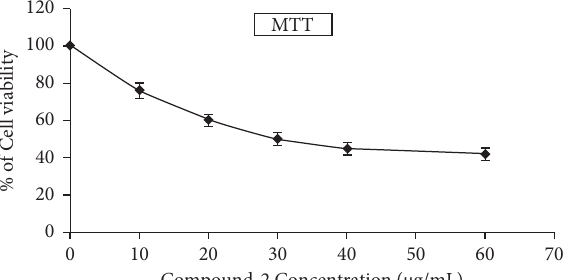
Figure 8: Effect of compound 2 on the viability of ovarian cancer cells. HO-8910 (1 × 10 4 /well) cells were cultured in RPMI 1640 medium supplemented with 10% FBS and incubated with indicated concentrations of compound 2 for 24h. For cell viability assay, cells were exposed to different doses (0–60 μ g/ml) of compound 2 for 24 h, and compound 2 inhibits growth (as determined by MTTassay) of HO-8910 cancer cells. Each bar represents the mean ± SEM of five independent observations and the statistical significance between the control and treated groups at p < 0 . 05 level.